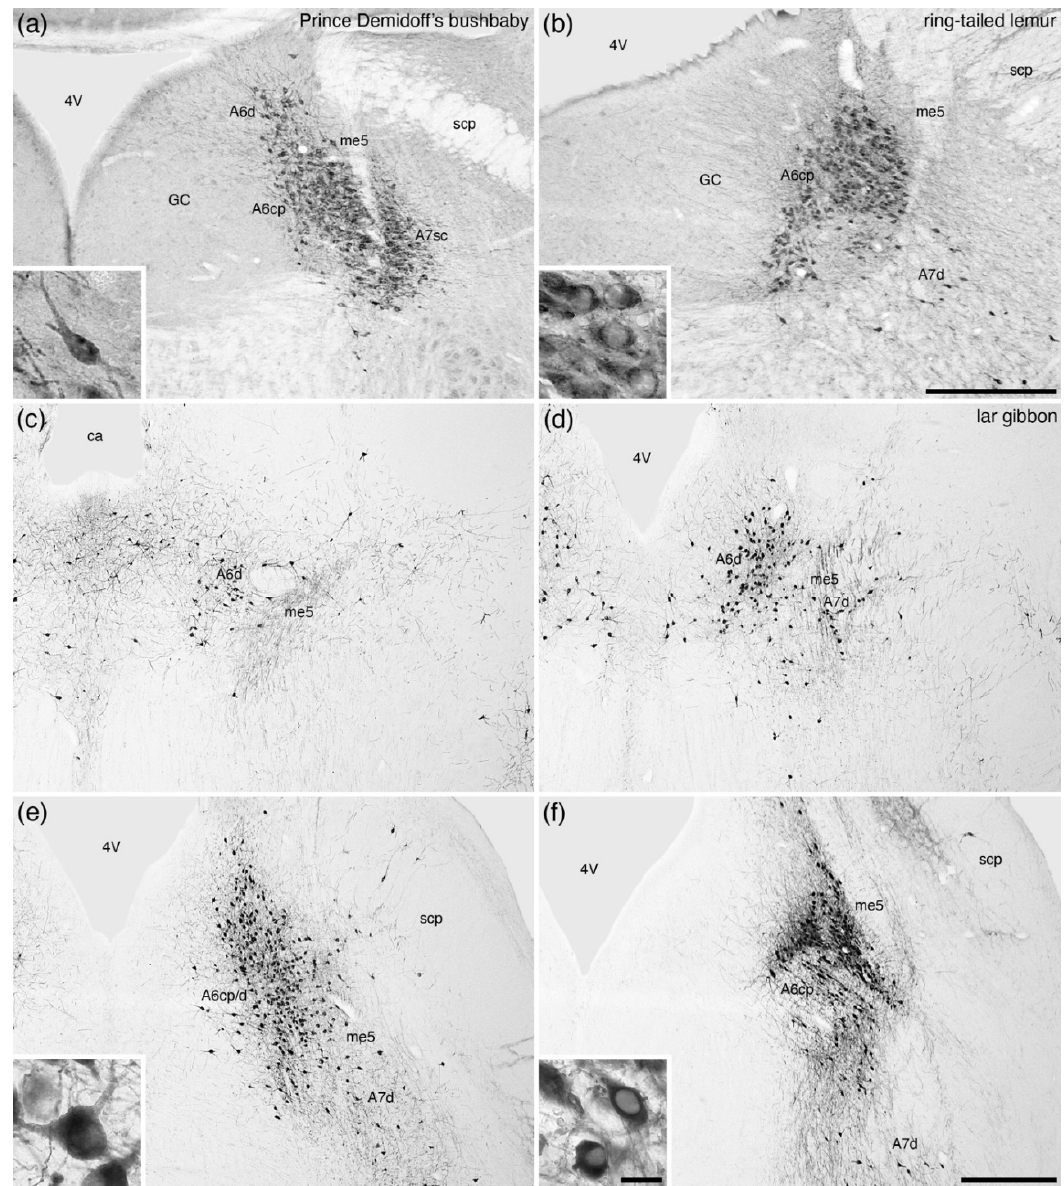
Figure 7. Low-magnification photomicrographs of the locus coeruleus ( A6 ), revealed with tyrosine hydroxylase immunostaining, in the brains of three species of primates, ( a ) Prince Demidoff’s bushbaby ( Galago demidoff ) [52], ( b ) ring-tailed lemur ( Lemur catta ) [52], and a rostro-caudal series, with each image being approximately 1 mm apart, through the A6 of the lar gibbon ( Hylobates lar ) [58]. Note the presence of both diffuse ( A6d ) and compact ( A6cp , compact portion of the locus coeruleus, primate-type) portions of the A6 in primates, with the caudal end of the A6 ( d ) showing the region of highest density of immunostained neurons. Insets in ( a , b , e , f ) show a high-magnification image of the neurons from the A6d ( a , e ) and A6cp ( b , d ). In all images, dorsal is to the top and medial to the left. Scale bar in ( b ) = 500 µm and applies to ( a , b ). Scale bar in ( f ) = 1 mm and applies to ( c – f ). Scale bar in inset f = 25 µm and applies to all insets. 4V —fourth ventricle; ca —cerebral aqueduct; GC —periventricular grey matter of the rostral hindbrain; me5 –fifth mesencephalic tract; scp —superior cerebellar peduncle.